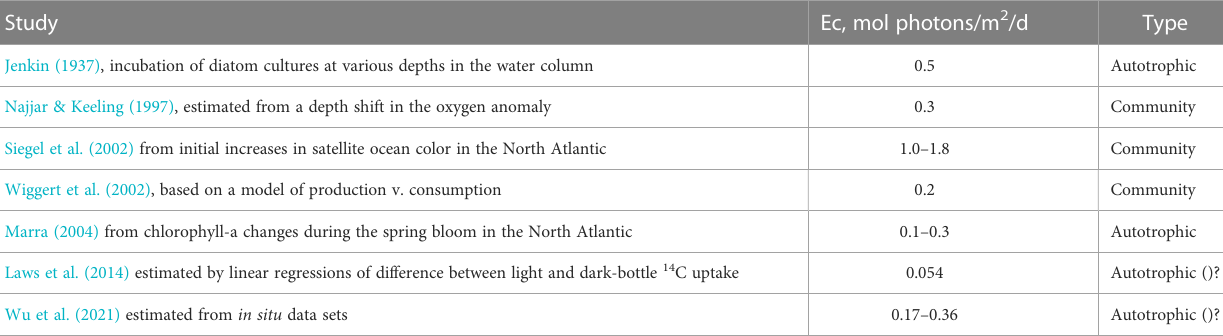
TABLE 1 Literature values of the compensation depth estimated in nature.